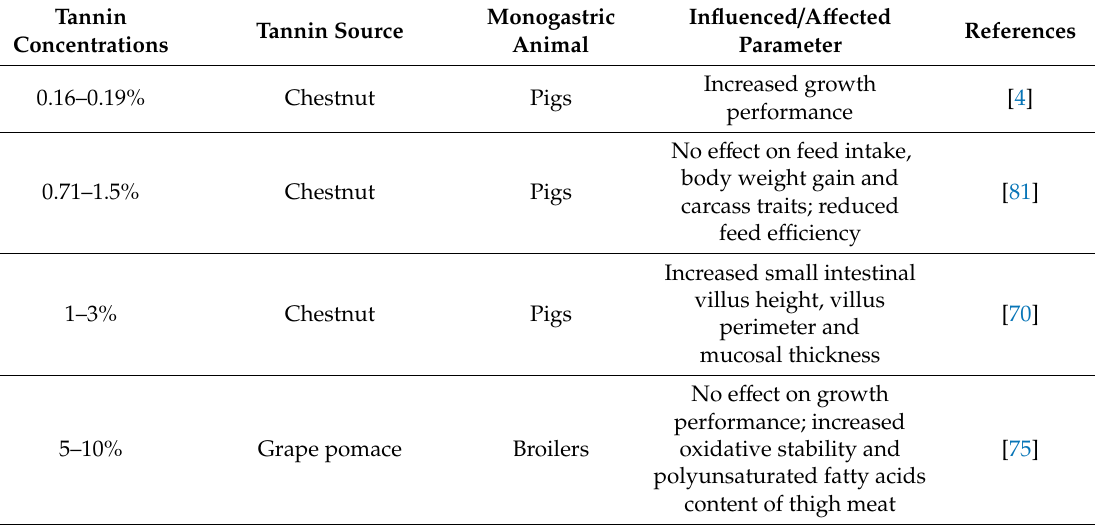
Table 4. E ff ects of tannins on productivity of monogastric